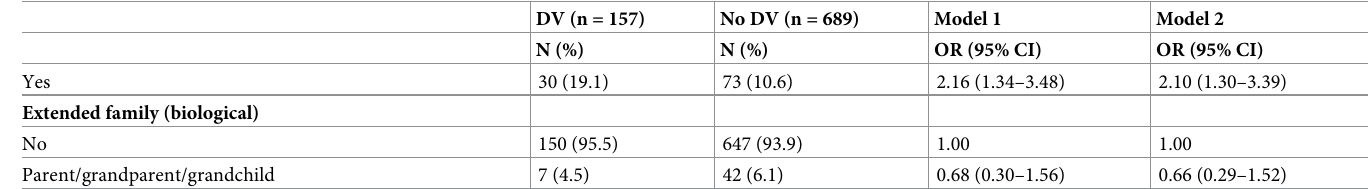
ilar prevalence of DV in Kandy. Strong and consistent associations between current depression chronic illness/disability, perceived low social support and DV were found overall. The pres- ence of in-laws, having three or more children, and being divorced, separated or widowed were also associated with DV. There was no strong statistical evidence that associations dif- fered by sex for almost all study variables, although there was some weak statistical evidence that lower social support in the household was associated with greater DV in women com- pared to men, and this was in the opposite direction for community support.